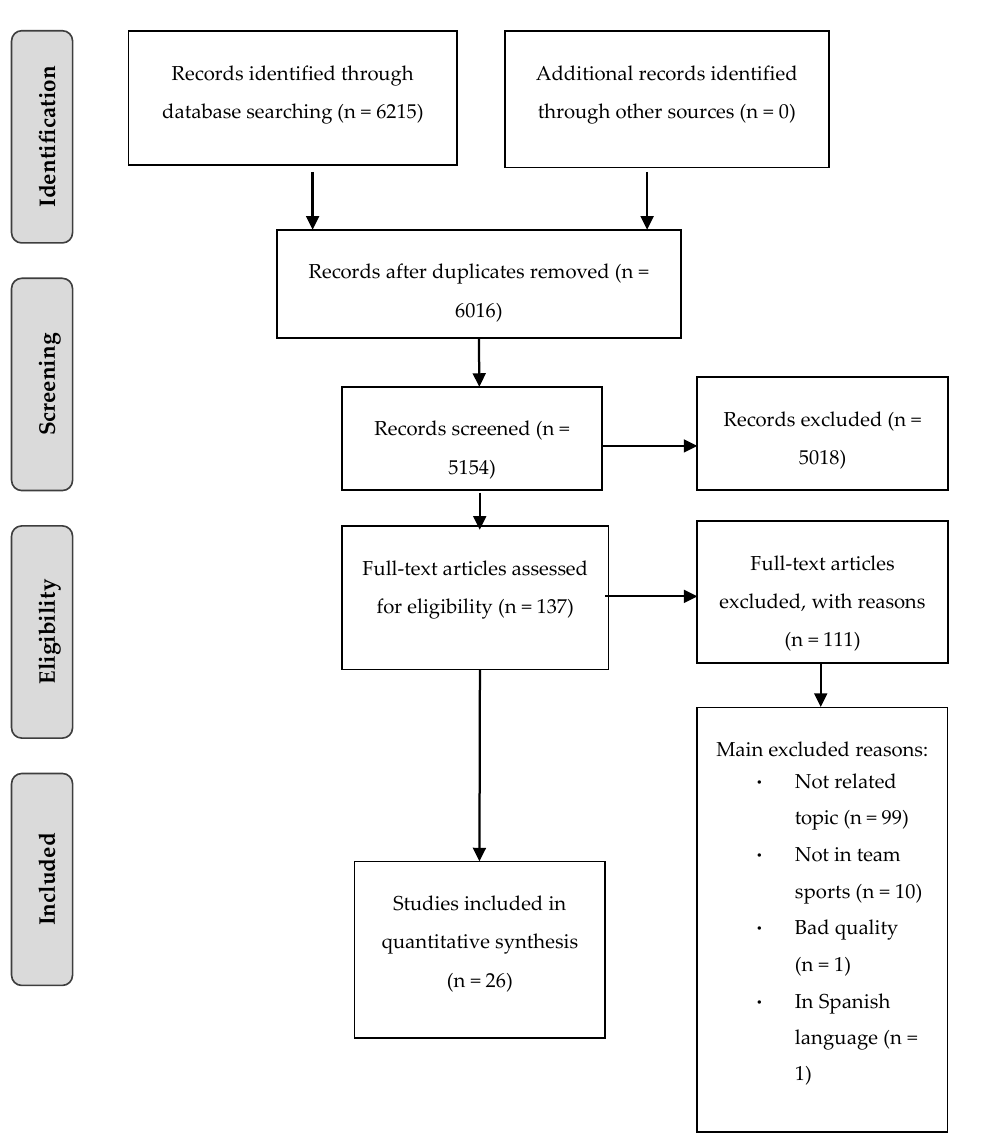
Figure 1. PRISMA flow diagram.